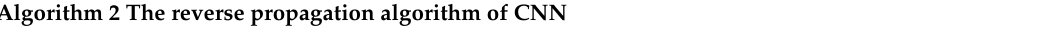
Algorithm 2 The reverse propagation algorithm of CNN 1 //process of the reverse